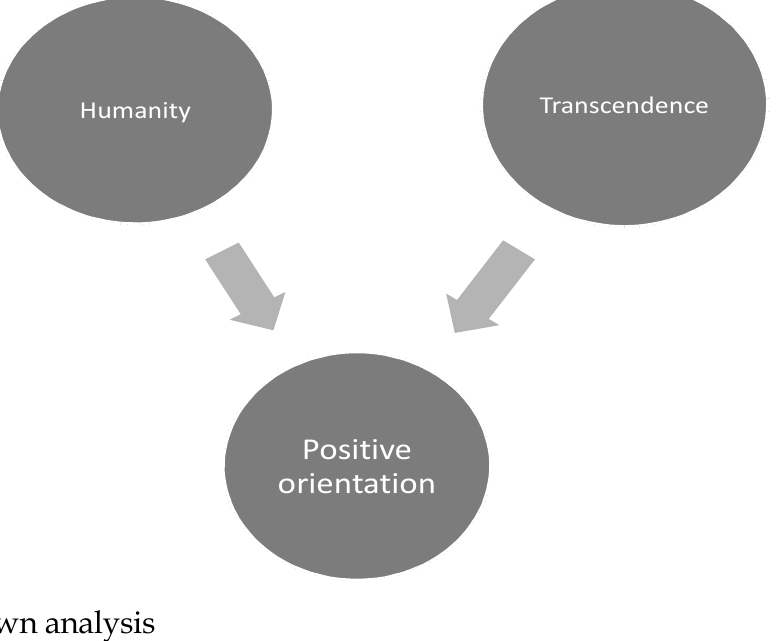
Fig. 2. Predictors of positive orientation in the test